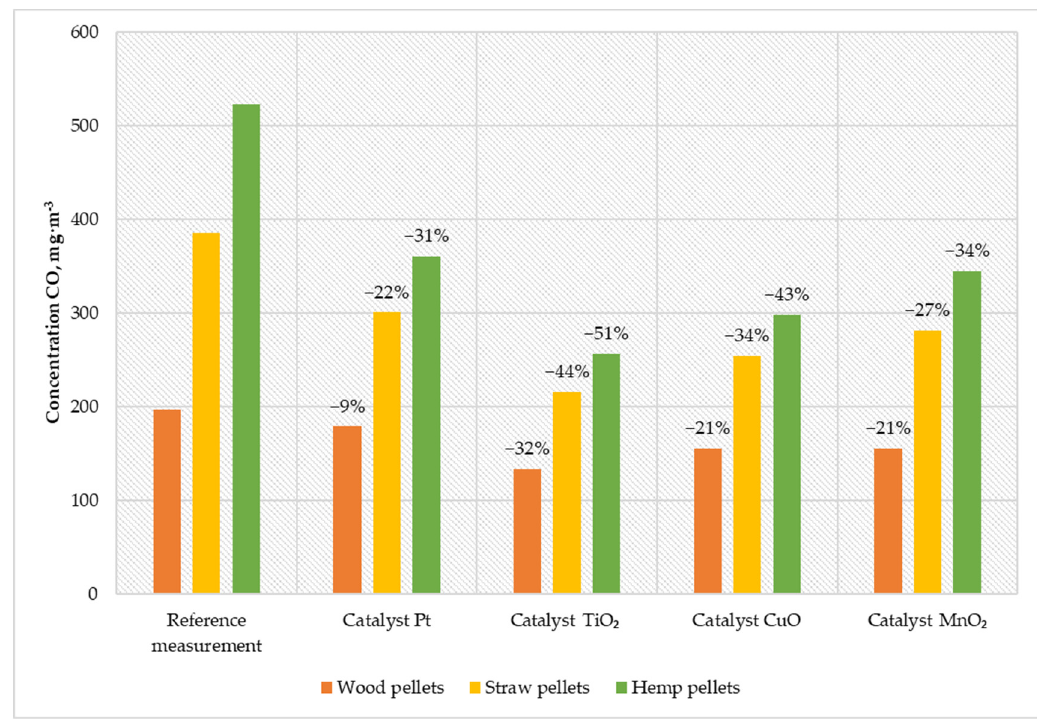
Figure 5. Average CO content in the flue gas from a low-power biomass boiler.